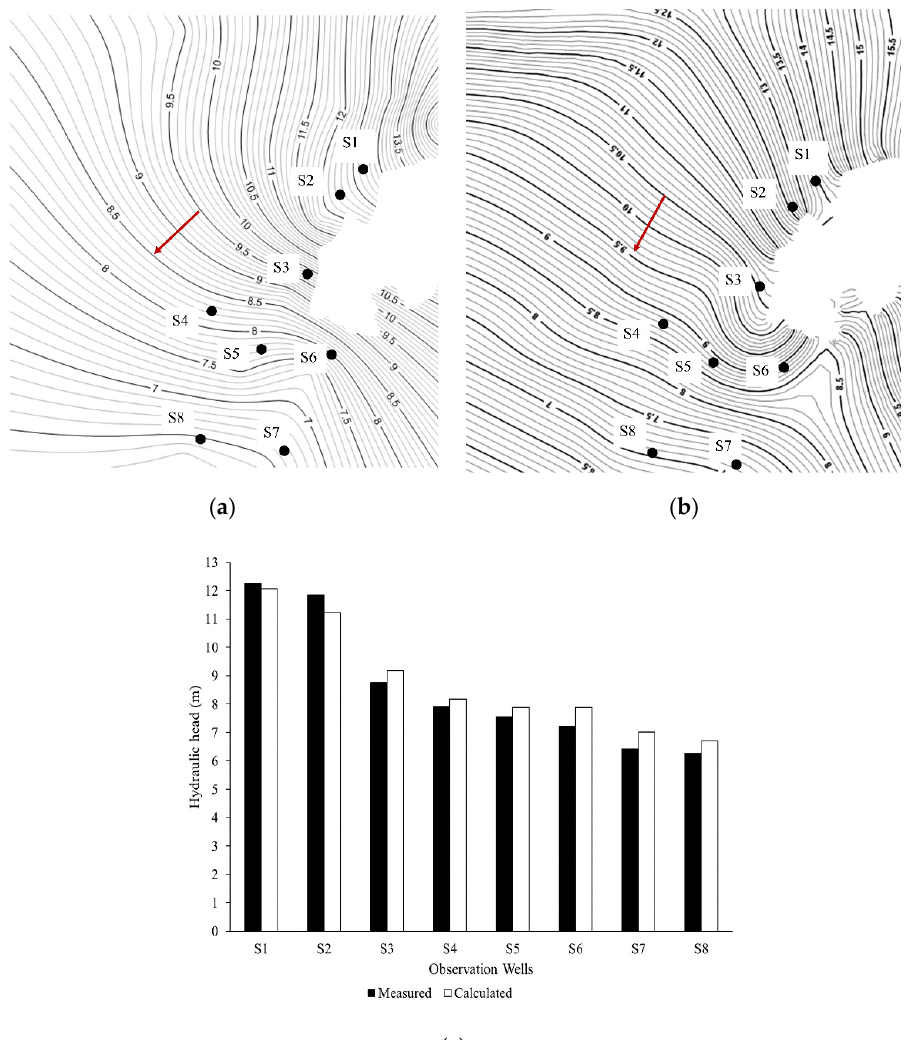
Figure 8. ( a ) Distribution of hydraulic head in the Nagara River alluvial fan by measured data from (Ohtani et al. [10]), ( b ) Distribution of hydraulic head in the Nagara River alluvial fan by simulation results, ( c ) Comparison of the hydraulic head between the calculated and measured data.